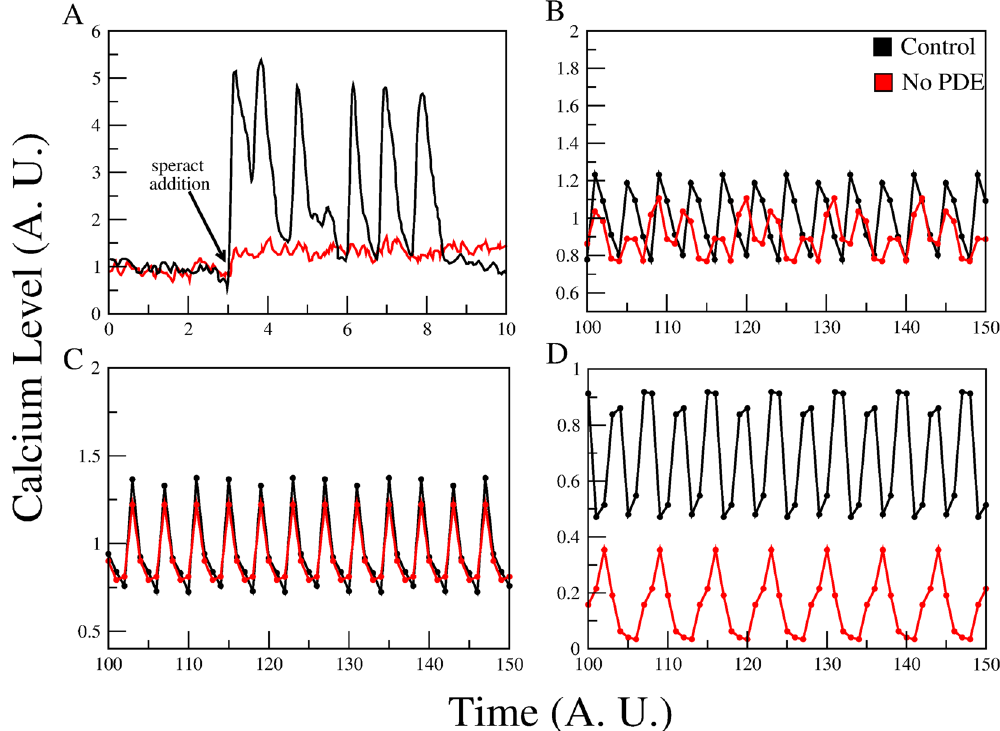
Figure 4. [ Ca 2 + ] i dynamics of the network model with and without the PDE node. Panel A shows a typical experimental measurement of [ Ca 2 + ] i florescence after exposure to speract. The control curve is depicted in black; the red curve represents the calcium level with speract + IBMX, a known PDE blocker. Note the considerable decrease in the Ca 2 + induced by PDE blockage. Panels B,C and D are the time series of the Ca 2 + level for the control curve (black) and under deletion of the PDE node (red) for Models I, II and III respectively. In the time series of panel B, the average calcium level is slightly lower and its oscillations smaller under PDE deletion. Model-II (panel C) remarkably displays only small changes. However, for Model-III (panel D), the calcium level under PDE-blockage is drastically